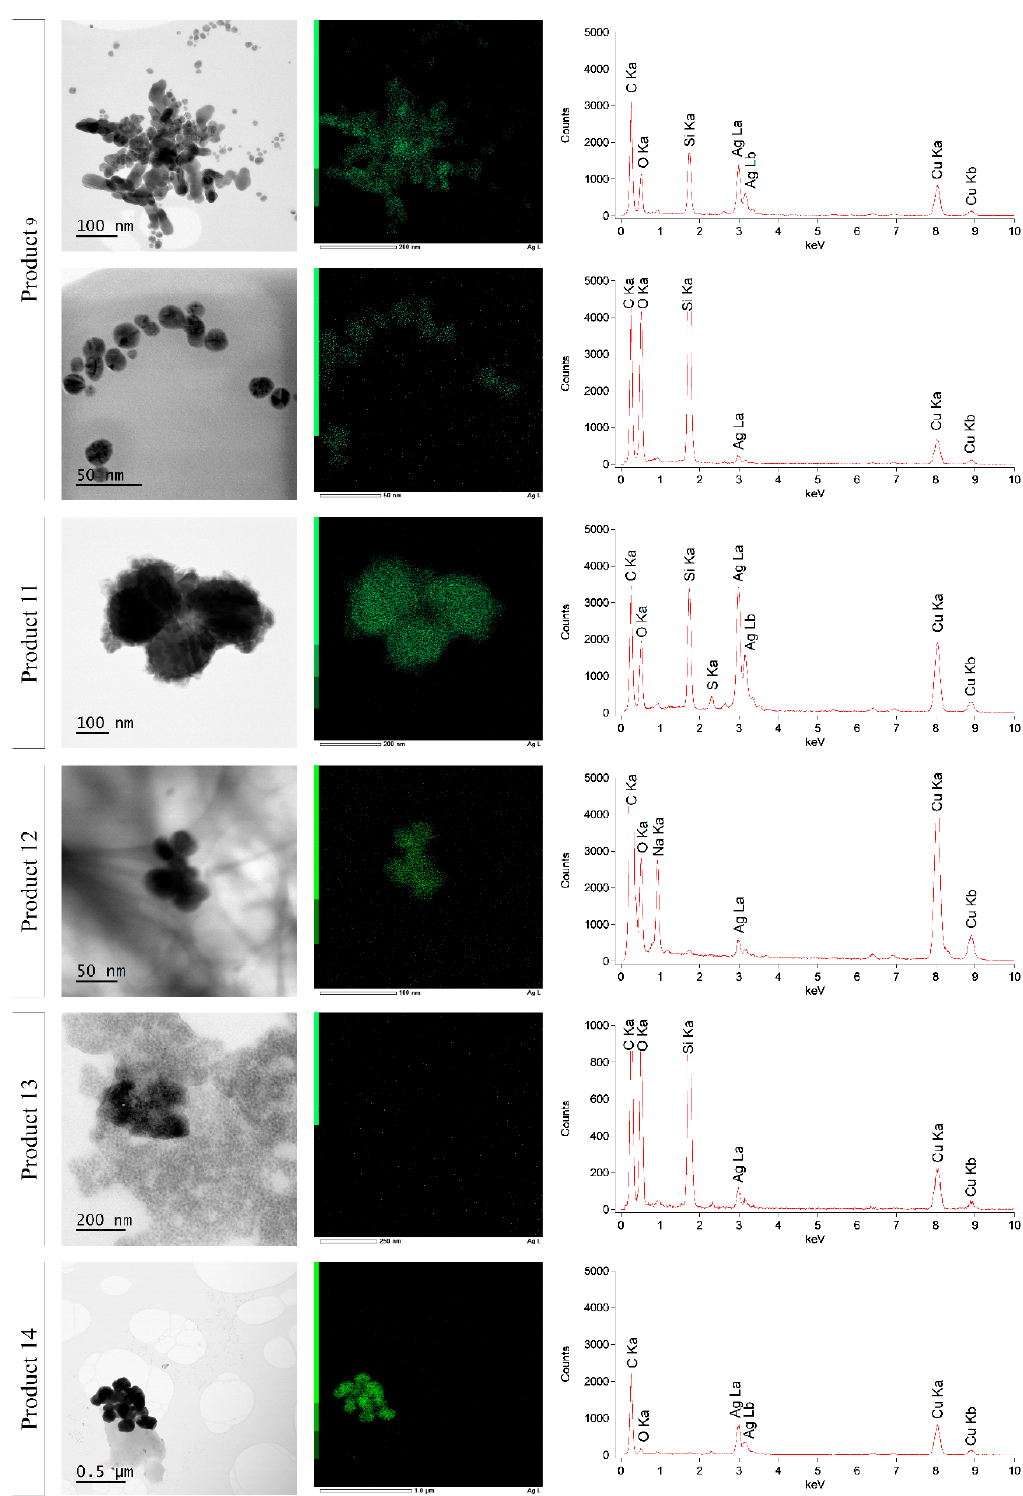
Figure 9. STEM ‐ EDX results of products 9, 11, 12, 13, and 14. Batch 1 is represented for product 9.